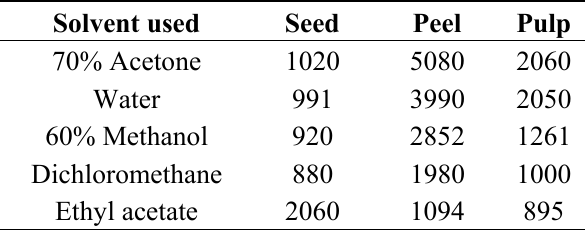
Table 4. Total phenolic contents of various parts of fresh and frozen fruit (mg GAE/100 g) [46].